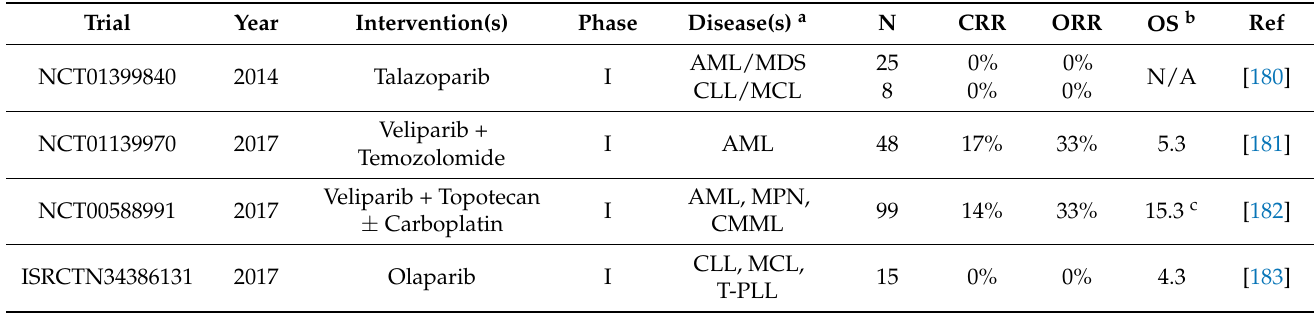
Table 3. Published Clinical Trials of PARP Inhibitors in Hematologic